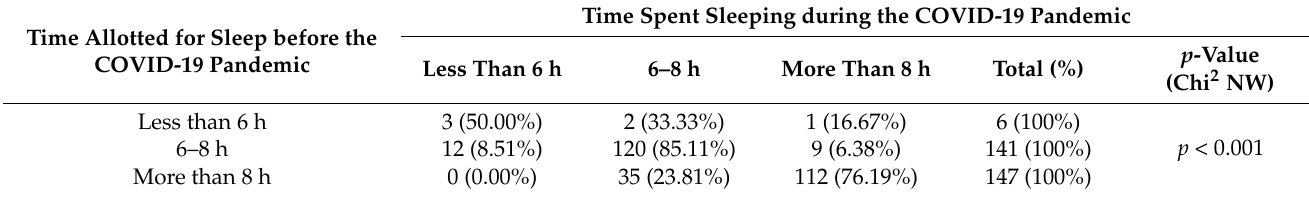
Table 7. Length of time spent sleeping before and during the COVID-19 pandemic.